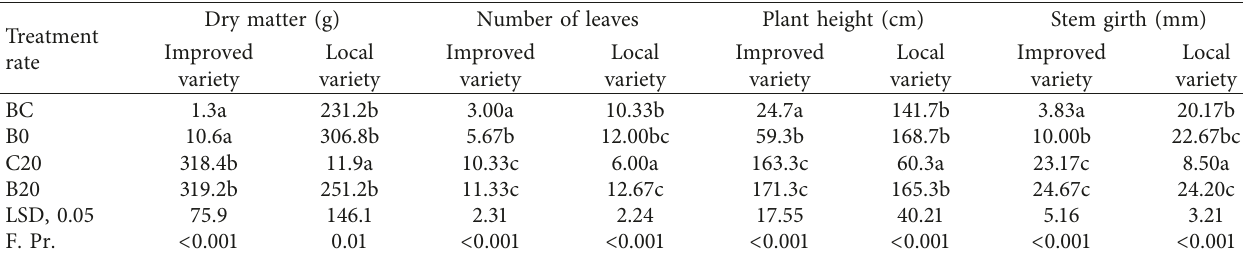
Table 5: Effects of biochar and/or compost applications on the plant growth performance of maize crop (local and improved varieties) grown on the Aiyinase soil over 40-day period.